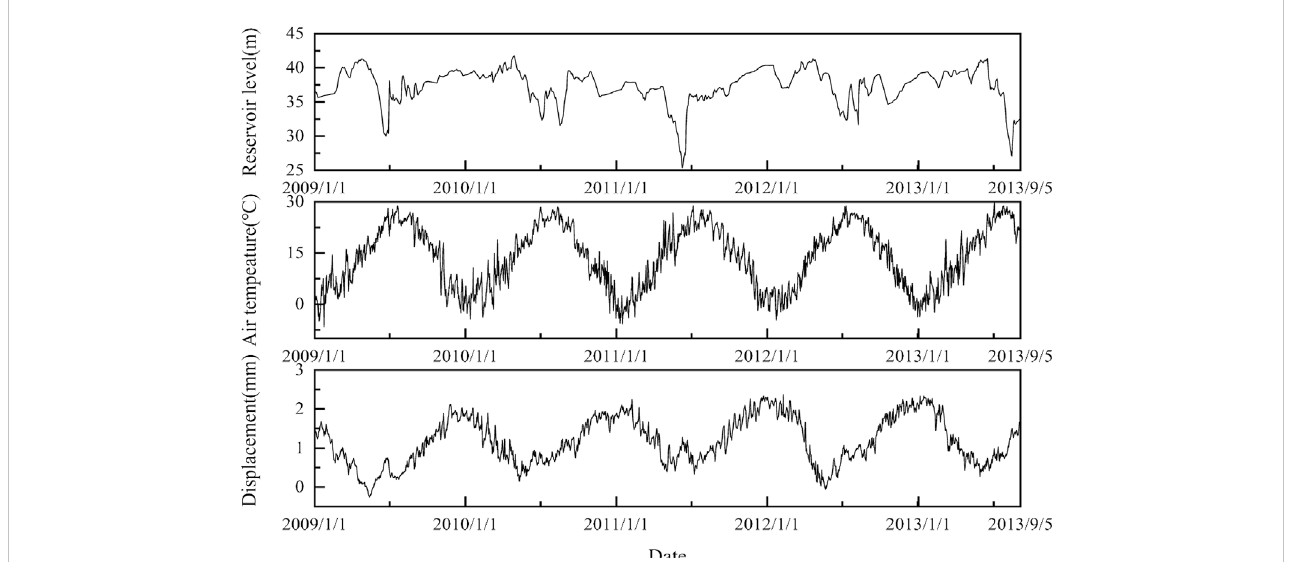
FIGURE 9 Reservoir level, air temperature, and displacements recorded in the dam section 13.